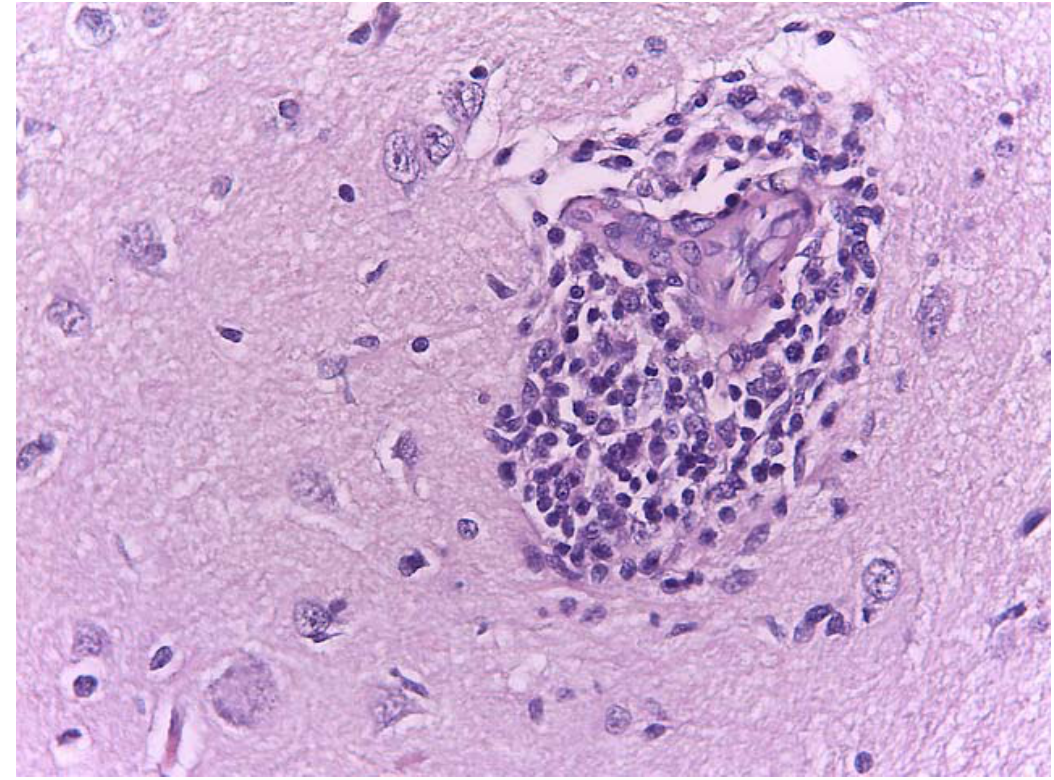
A spongy degeneration with vacuolization, variable in size and number, was ob- Figure 8. Perivascular cuffing of macrophage–lymphocyte cells. H&E. Magnification: 40 ×. served, especially in the gray matter (Figure 9).